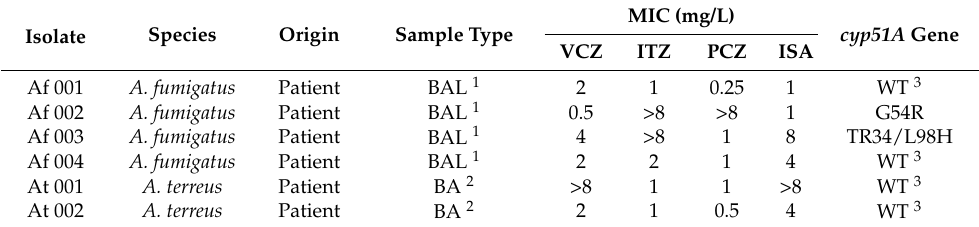
Table 2. Characteristics and in vitro antifungal susceptibility profiles of azole-resistant Aspergillus spp. isolates ( n = 6) from clinical